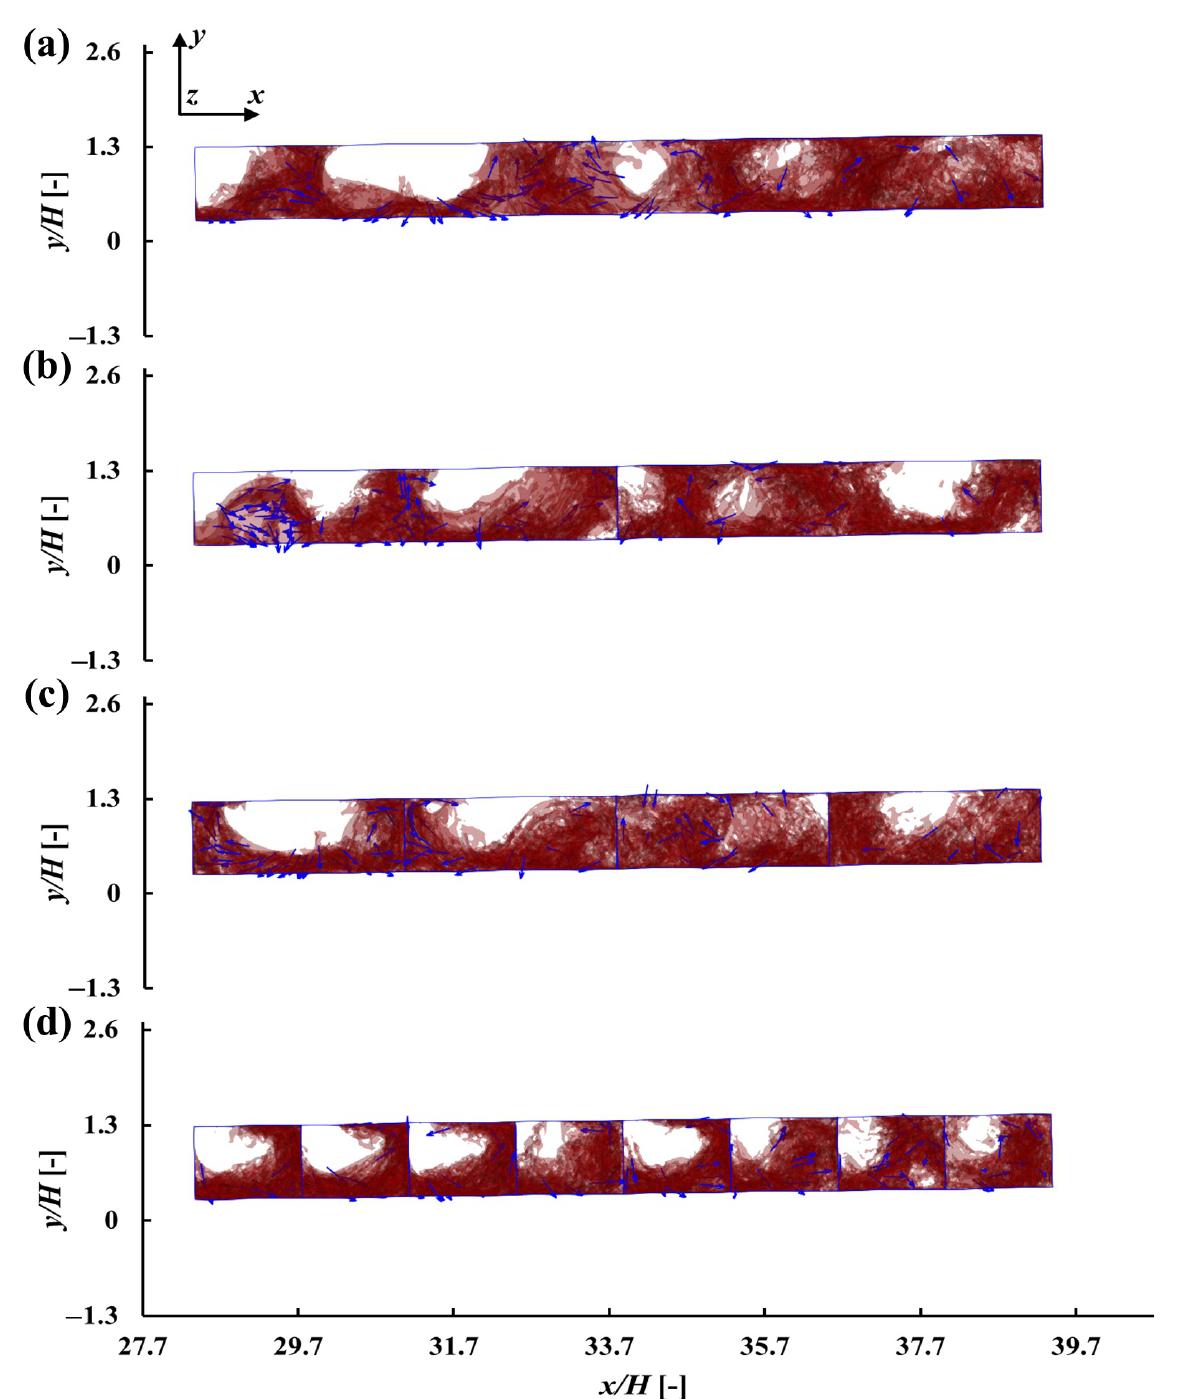
Figure 21. Snapshots for the sloshing tank with D i = 0.5 at t / T = 5.5 for ( a ) N c = 1, ( b ) N c = 2, ( c ) N c = 4 and ( d ) N c = 8. Water phase is shown as transparent red with dark red representing the free surface. Blue arrows show the general direction of motion of the sloshing